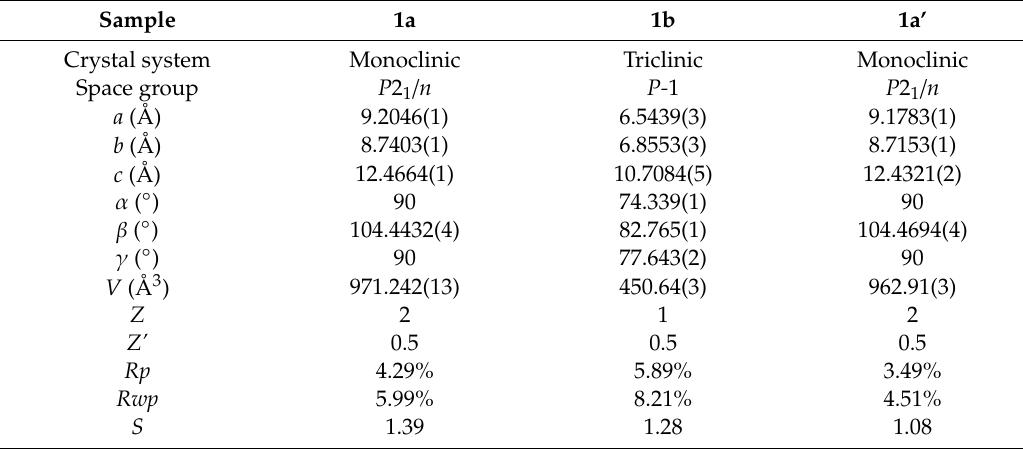
Figure 3. Results of Rietveld refinements for the crystal structures of 1a, 1b, and 1a’ . Symbols (x) represent the observed profile intensities, blue lines represent the calculated profiles, and the differences between both intensities at the bottom of each pattern on the same intensity scale. Table 1. Crystallographic data of samples 1a , 1b , and 1a’ .